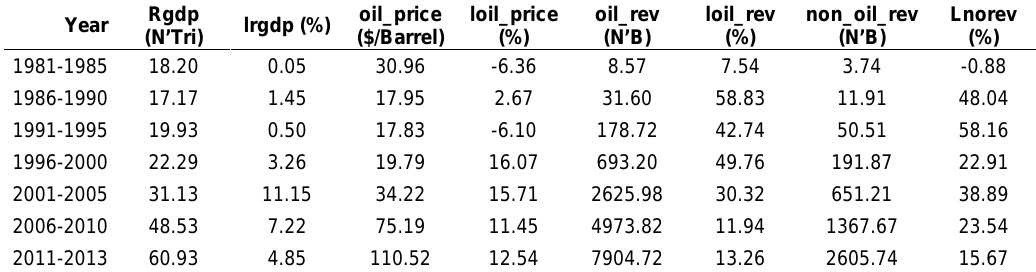
Table 1. The Values and the Growth rates of real GDP, Oil Prices, Oil Revenues and Non-Oil